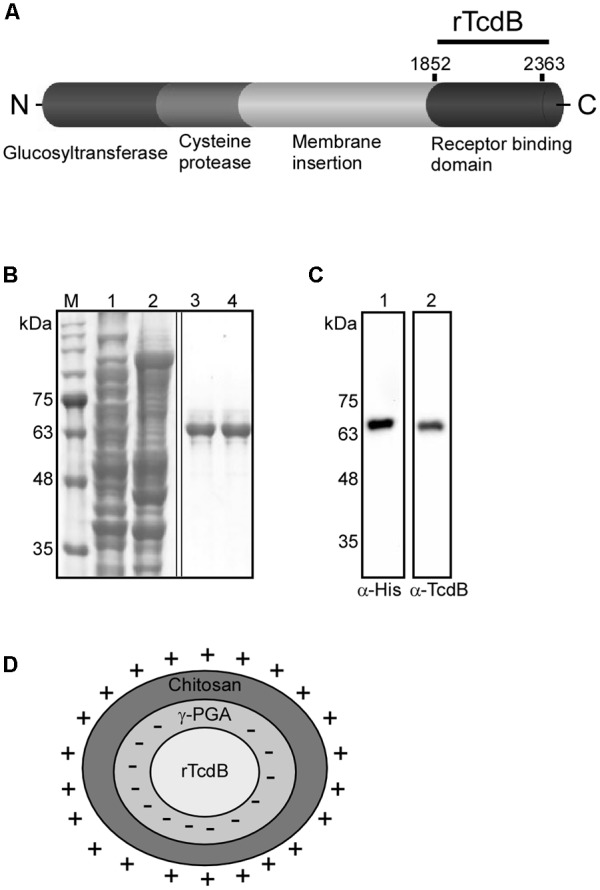
Purification of recombinant TcdB and the composition of NP-rTcdBs. (A) Functional domains of TcdB and regions included for nanoparticle vaccine construction. (B) Coomassie blue staining of purified rTcdB. rTcdB were purified from E. coli by His-tag affinity chromatography. Lanes 1 and 2: Total E. coli lysates containing rTcdB and unbound proteins. Lanes 3 and 4: Purified rTcdB with. (C) Immunoblotting confirmation of rTcdB. M. Protein markers. rTcdB from SDS-PAGE was transferred to a membrane and detected by anti-His (lane 1) and anti-TcdB (lane 2). (D) Composition of NP-rTcdBs. The ionized chitosan and γ–PGA were able to form polyelectrolyte complexes via electrostatic interactions, resulting in a matrix structure with a spherical shape.